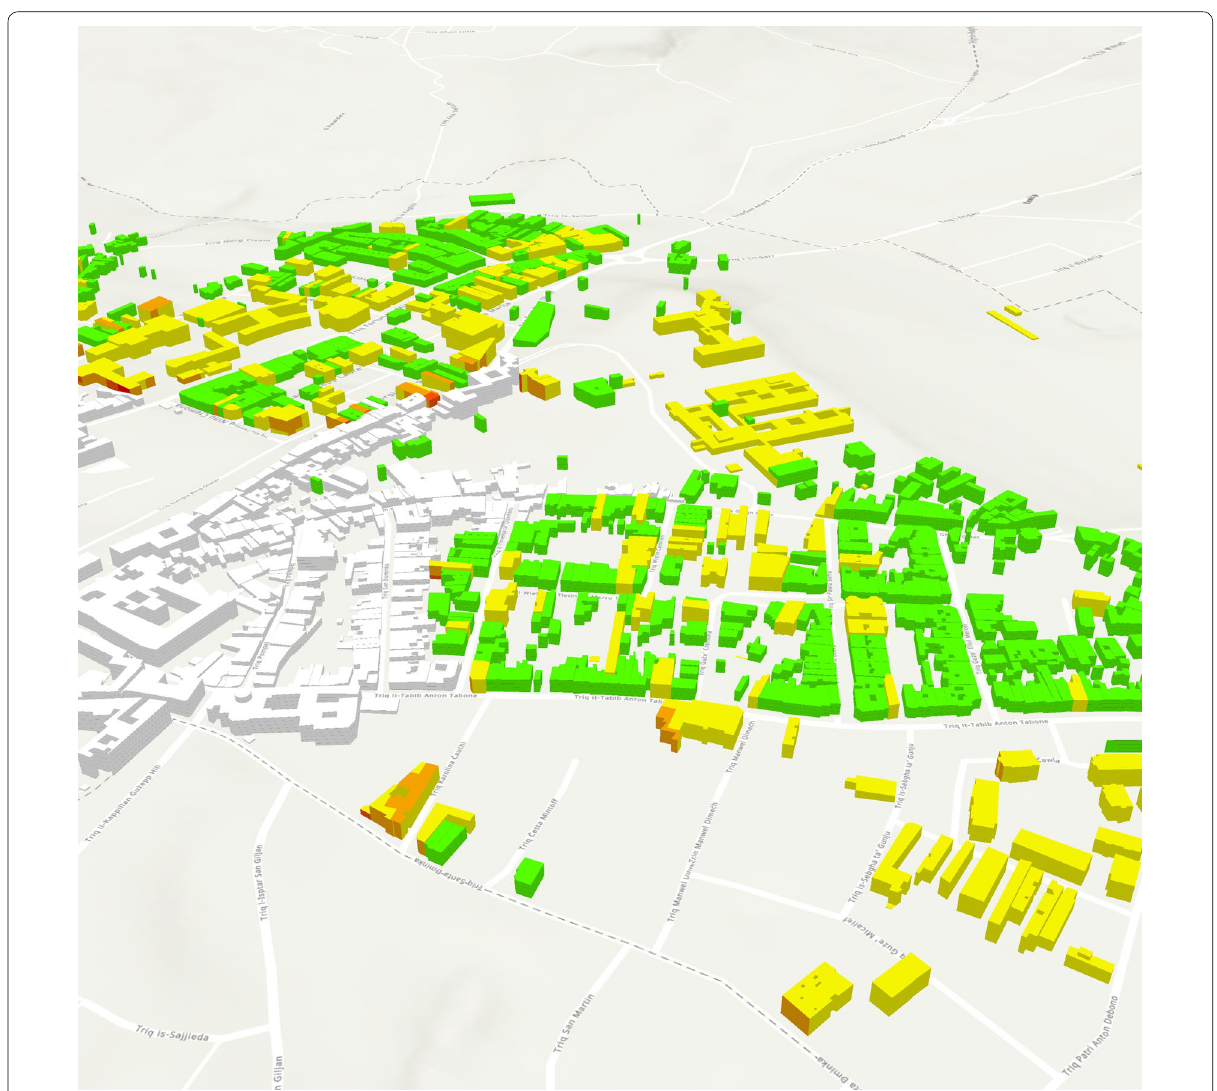
Fig. 15 Extract from the results of the visibility analyses carried out on the proposed future state of the built-up south-eastern area of